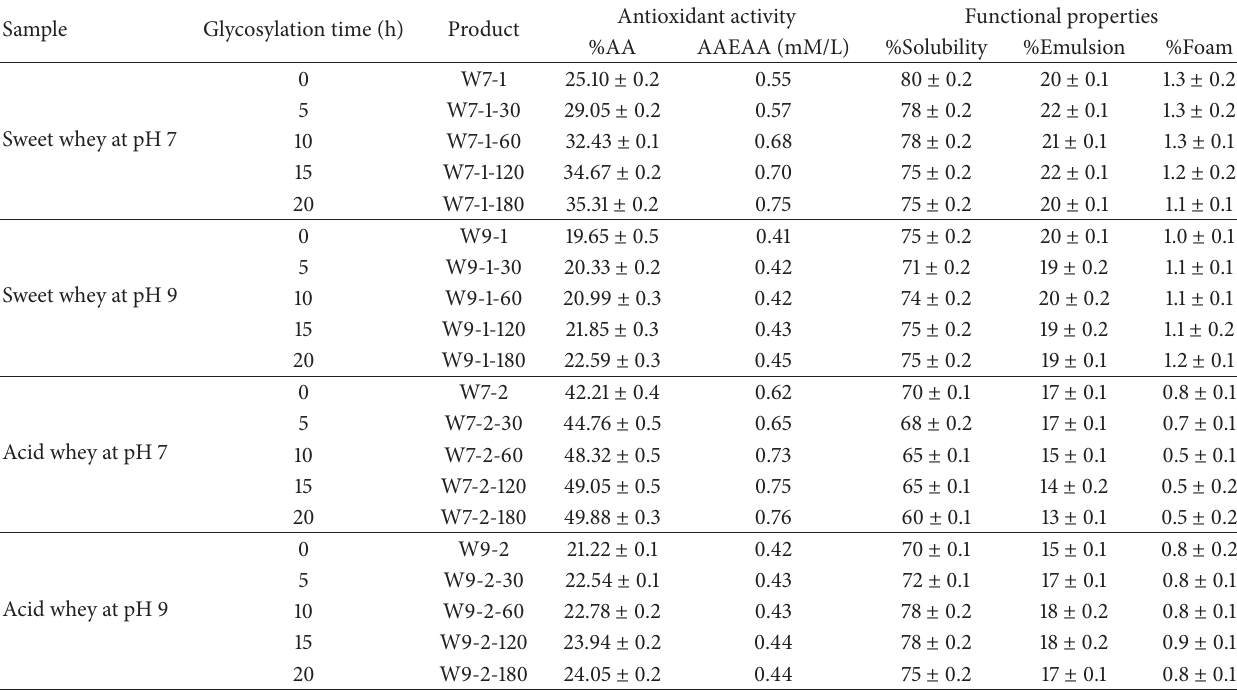
Table 2: Features of glycosylated product from sweet and acid whey with heating to 50 ∘ C, pH 7 and pH 9.